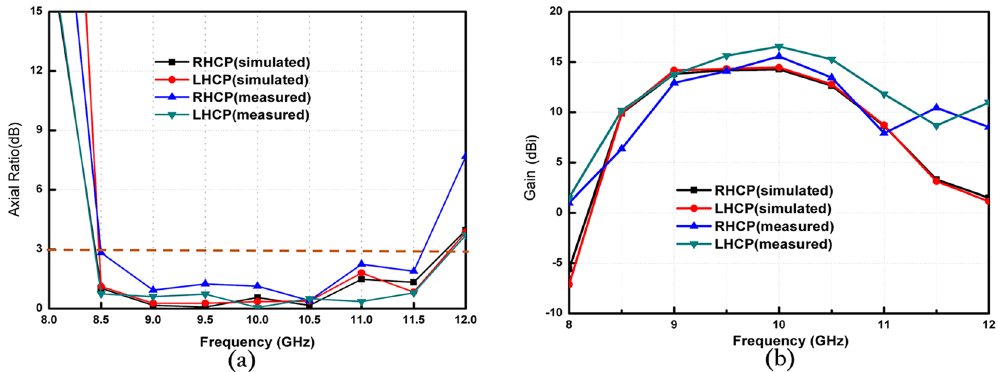
Figure 7. Simulated and measured ( a ) axial ratios and ( b ) gains of the LHCP and RHCP MAs.